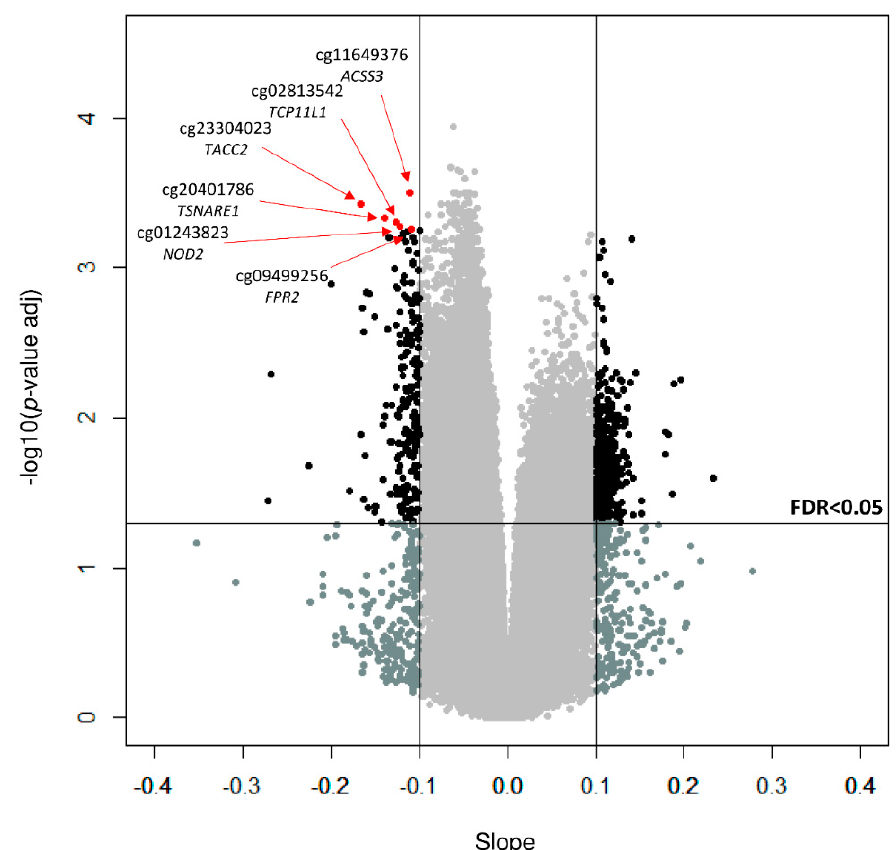
Figure 1. Volcano plot of waist circumference-associated CpGs (corresponding gene according to Illumina). Points above the horizontal line showed a false discovery rate (FDR) < 0.05 and outside the vertical lines represented a slope ≥ |0.1|.